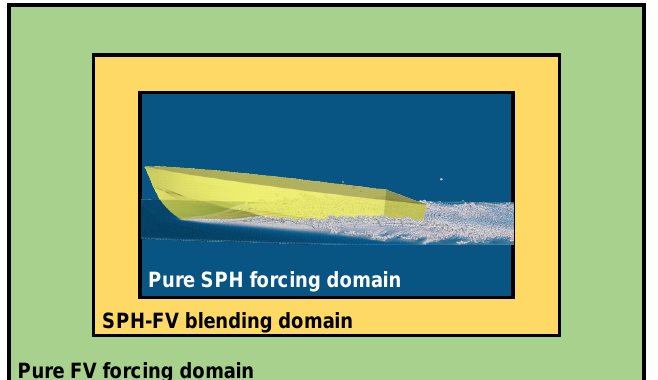
Figure 26. The schematic diagram of the SPH-FV coupling strategy proposed by Marrone et al.